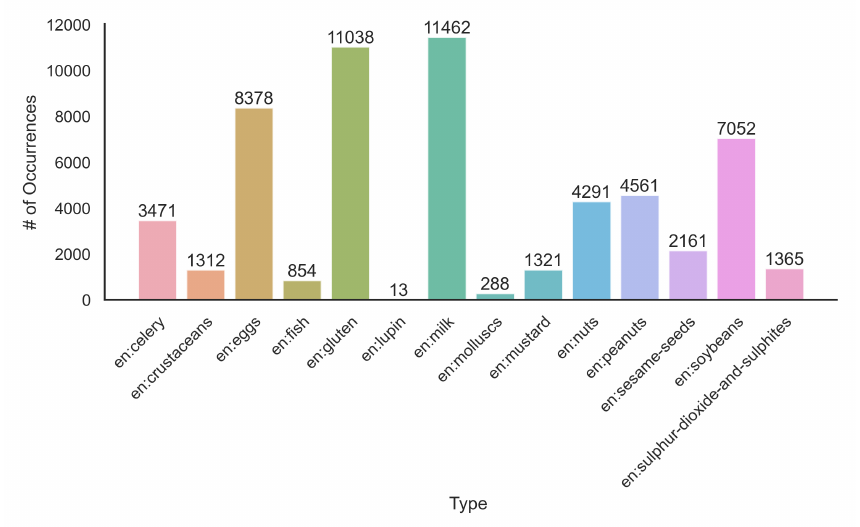
Figure 4. Class distribution of allergens in the cleaned dataset after downsampling is applied.